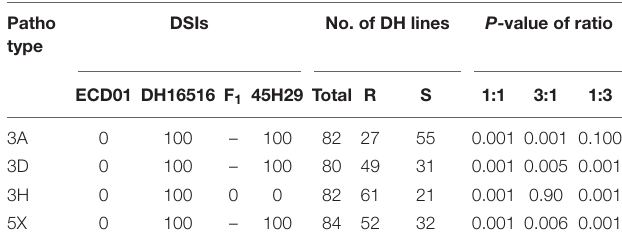
TABLE 1 | Genetic analysis of resistance of the parental lines (DH16516, ECD01), controls (cv. “45H29”), and the inoculation of doubled haploid (DH) population derived from BC 2 with four pathotypes of Plasmodiophora brassicae based on the clubroot severity (disease severity index, DSI) of each line (Resistant, R, DSI ≤ 30; Susceptible, S, DSI >